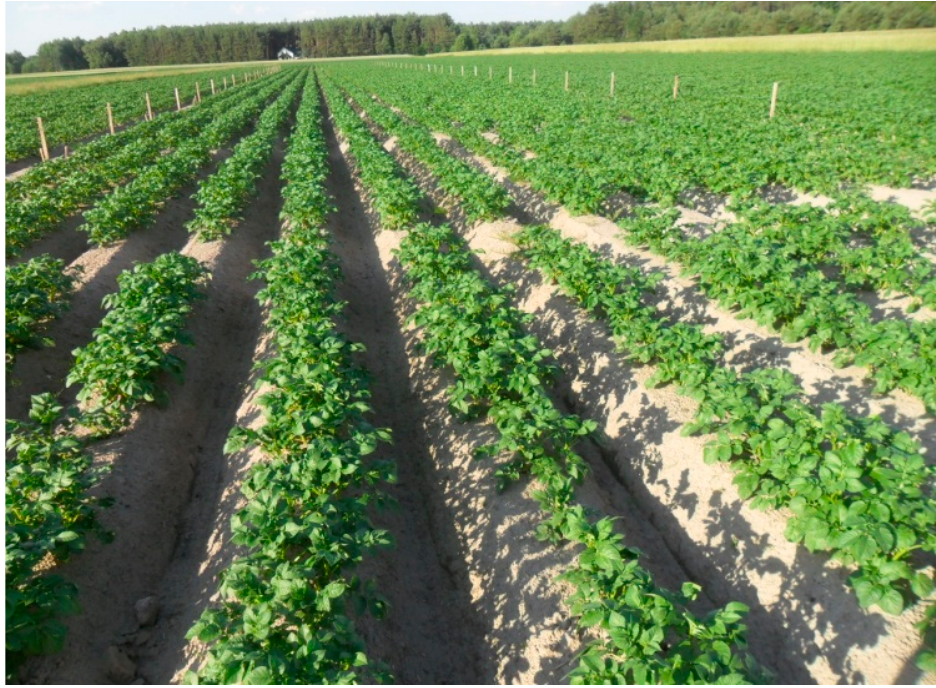
Figure 2. The farm field experiment in Kuklówka Zarzeczna (Central Poland), 50th potato growing day (photo. Niedzi ń ski T.).